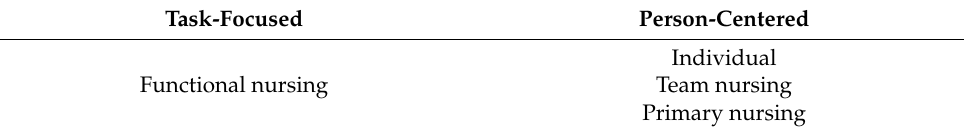
Table 1. Work methods in nursing.